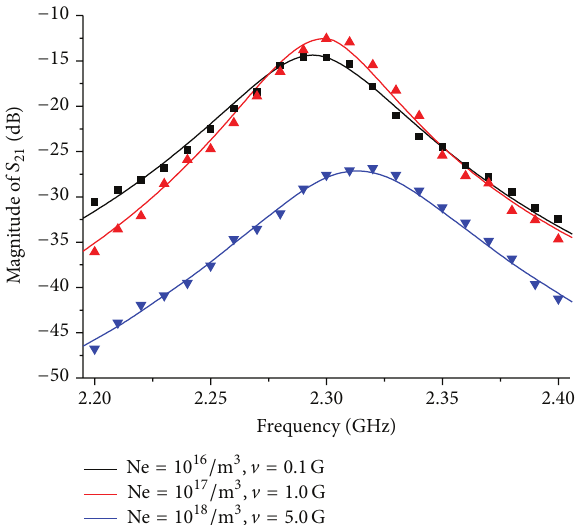
Figure 4: Comparisons between the results from the analysis method and the XFDTD simulation